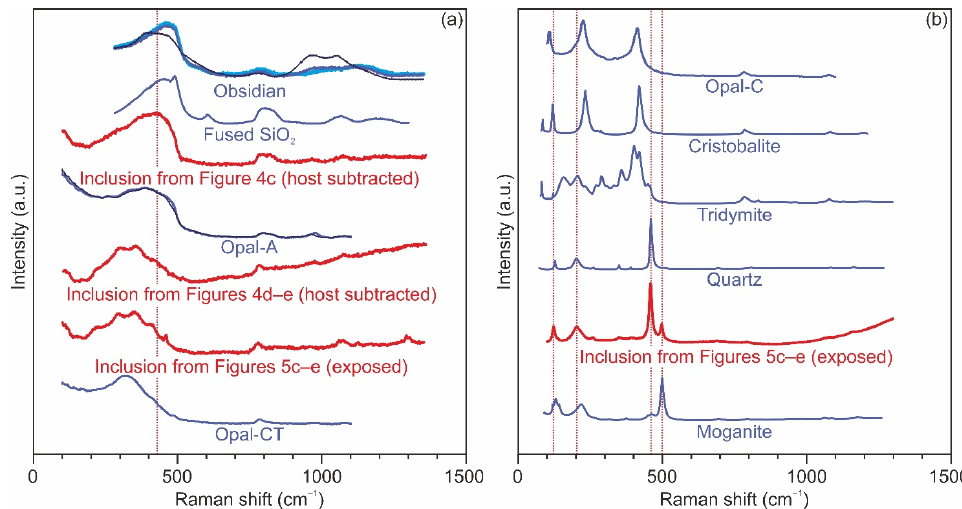
Figure 8. A comparison of selected Raman spectra from SiO 2 -rich fluid inclusions with those of various SiO 2 -rich amorphous phases and crystalline SiO 2 polymorphs from previous work [93,95,96]. ( a ) Spectra from amorphous phases (multiple spectra of obsidian and opal-A are shown). The vertical line at 430 cm − 1 shows the approximate location of the primary bands in these spectra. Note that the primary bands in the spectra of SiO 2 -rich glasses typically reach their maximum at higher frequencies, while those in the spectra of opals peak near this line or at lower frequencies. ( b ) Spectra from opal-C and crystalline phases. The vertical lines highlight the main peaks from the spectrum measured in this study.